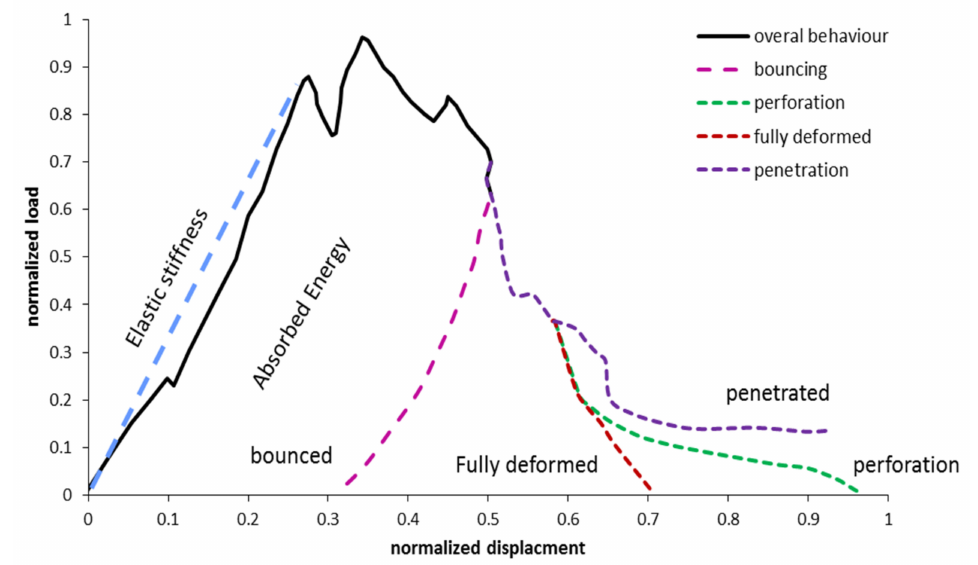
Figure 5. A typical load-deformation relation of an FRP composite plate under low-impact loading. Figure 6 indicates a typical plot of the load-displacement and energy-displacement curves for general FRP composites under impact loading. At the first peak load, the damage initiates with matrix cracking. The intersection of this point with the energy- displacement curve identifies the border between damage initiation and damage propaga- tion. The damage initiation point to the energy propagated region can be called the energy absorption